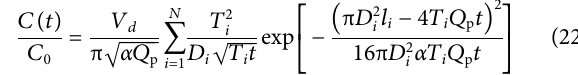
Frontiers in Energy Research |